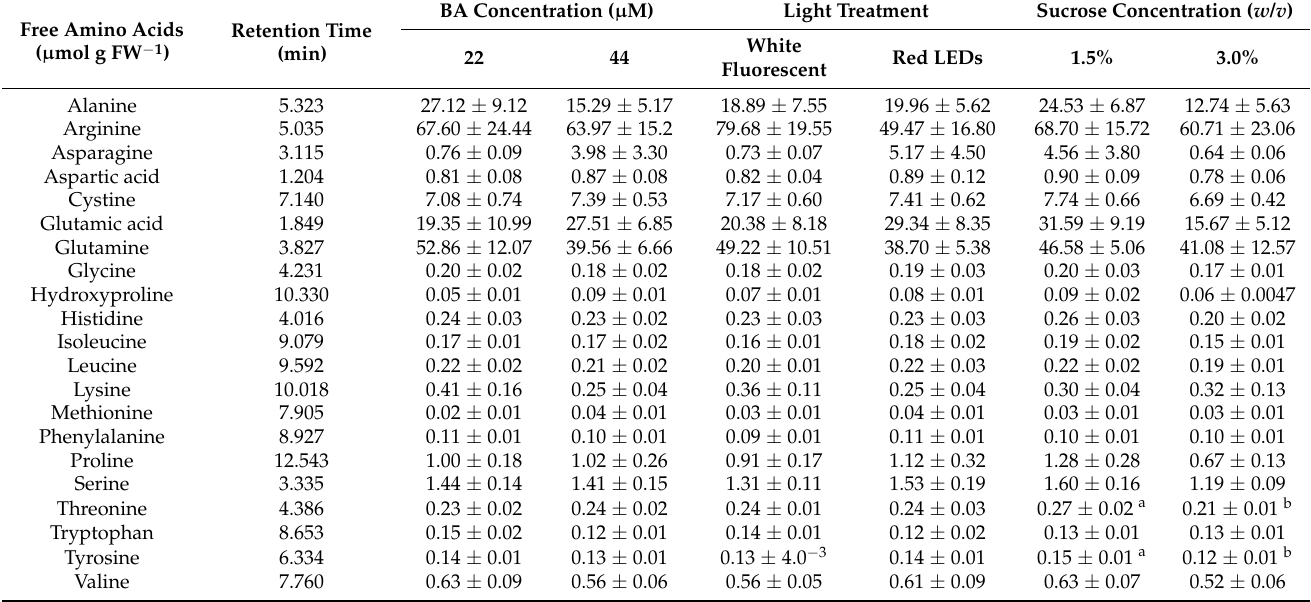
Table 4. Effect of 6-Benzyladenine (BA) (22 and 44 µ M) and sucrose concentration (1.5 and 3.0% ( w / v )) and light treatment (white fluorescent or red LEDs) on amino acid levels ( µ mol g FW − 1 ) of Pinus radiata D. Don shoots cultured in Quoirin and Lepoivre (LP) medium [27], modified according to Aitken-Christie et al. [28], supplemented with 2 gL − 1 activated charcoal after the rooting